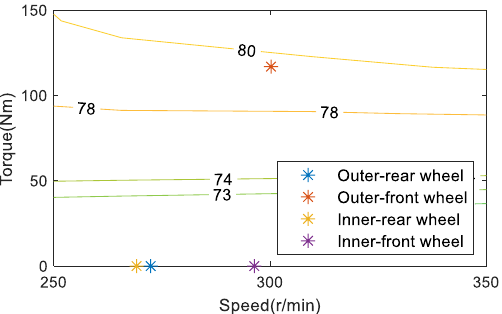
Figure 7. Working point of optimal torque distribution at 30 km/h.